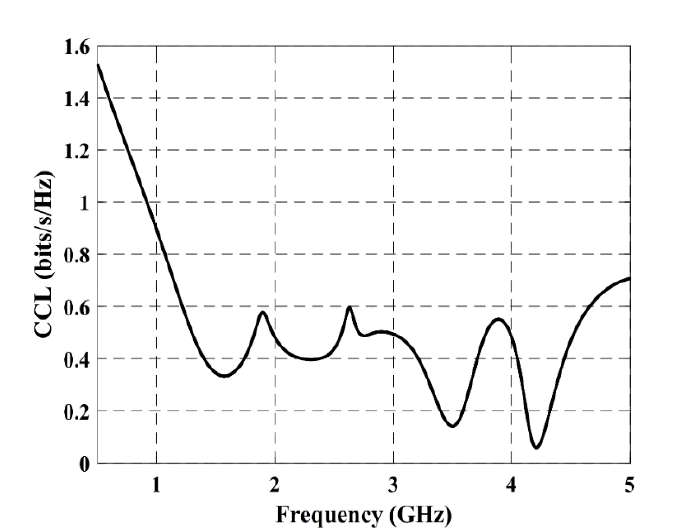
Figure 9. Measured performance for the channel capacity loss (CCL).